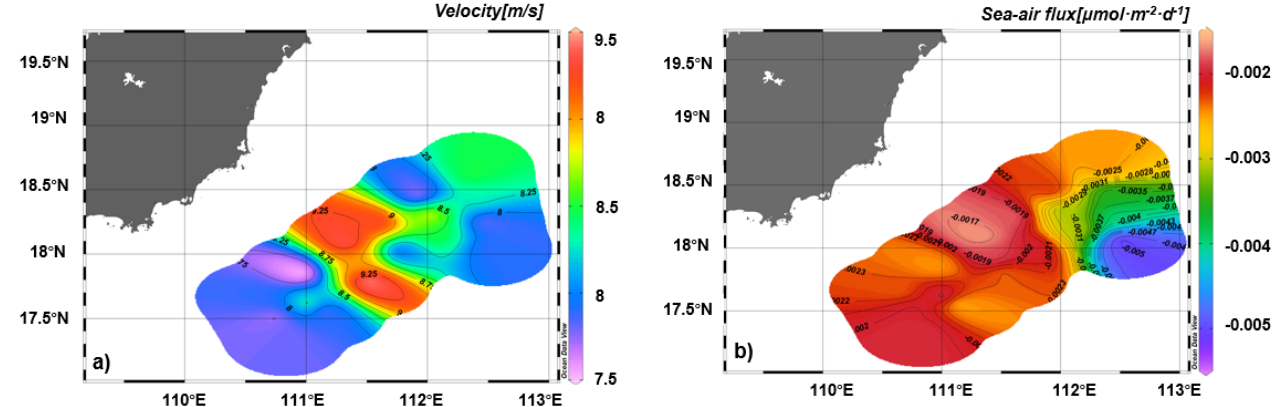
Figure 9. ( a ) Distribution map of average wind speed, and ( b ) sea–air methane exchange flux in the Qiongdongnan area in June 2019.